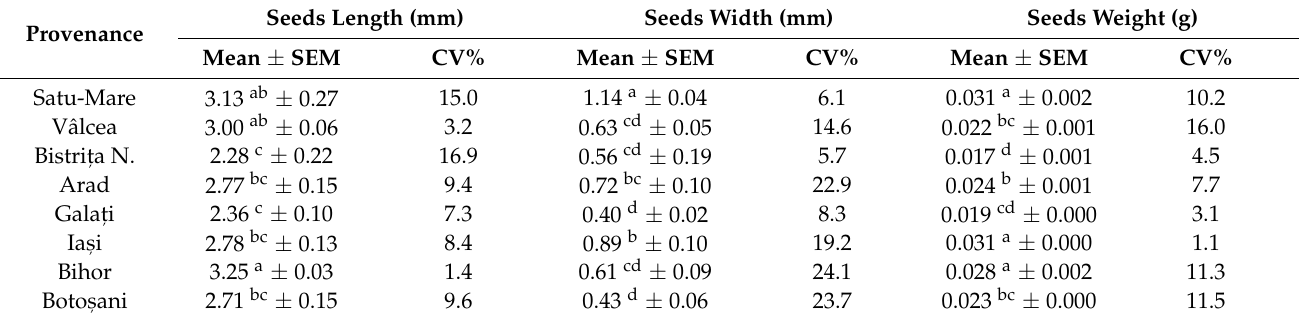
Table 2. The main morphological traits of the black locust seeds, as mean * and standard error of the mean (SEM).